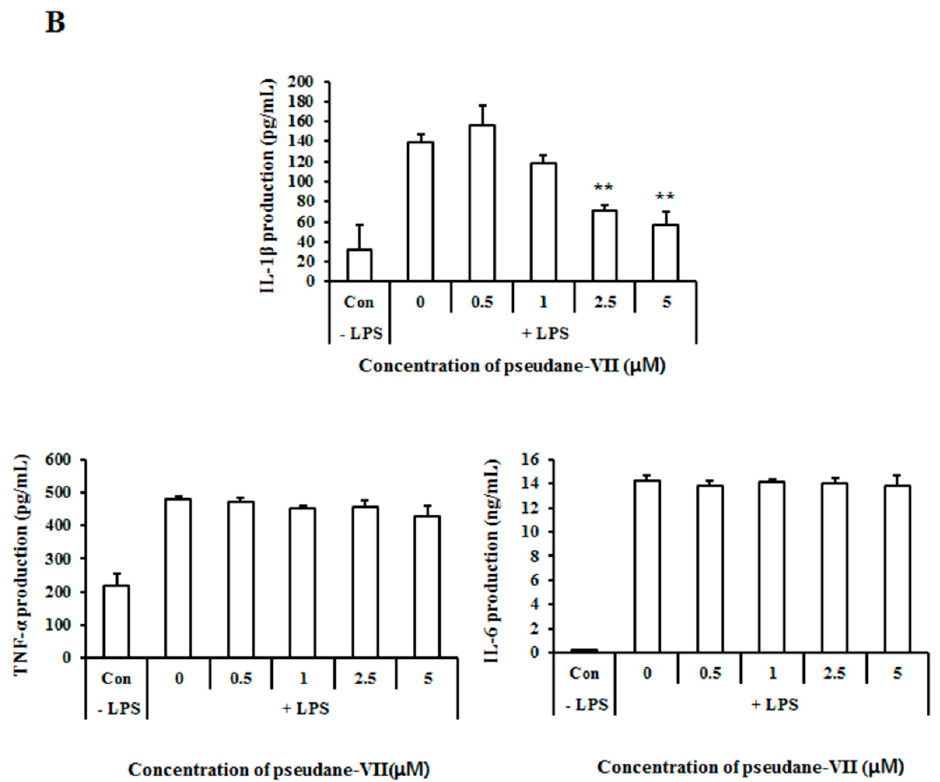
Figure 4. Pseudane-VII decreases LPS-induced pro-inflammatory cytokines. ( A ) BV-2 microglial cells were pretreated with diverse concentration (0.5, 1, 2.5, and 5 μ M) of pseudane-VII for 2 h and then stimulated with LPS (200 ng/mL) for 6 h. Expression levels of mRNA were measured by RT-PCR. ( B ) Cells (2 × 10 4 cells/well) were seeded in 96-well culture plates and then were pretreated with pseudane-VII (0.5, 1, 2.5, and 5 μ M) for 2 h. Pretreated BV-2 microglia cells were added with LPS (200 ng/mL) for 22 h. Supernatants were collected for cytokine release. IL-1 β , TNF- α , and IL-6 were measured by ELISA kit. Results are expressed as means (±SE) from three independent experiments. (** p < 0.001 vs. LPS-stimulated group).